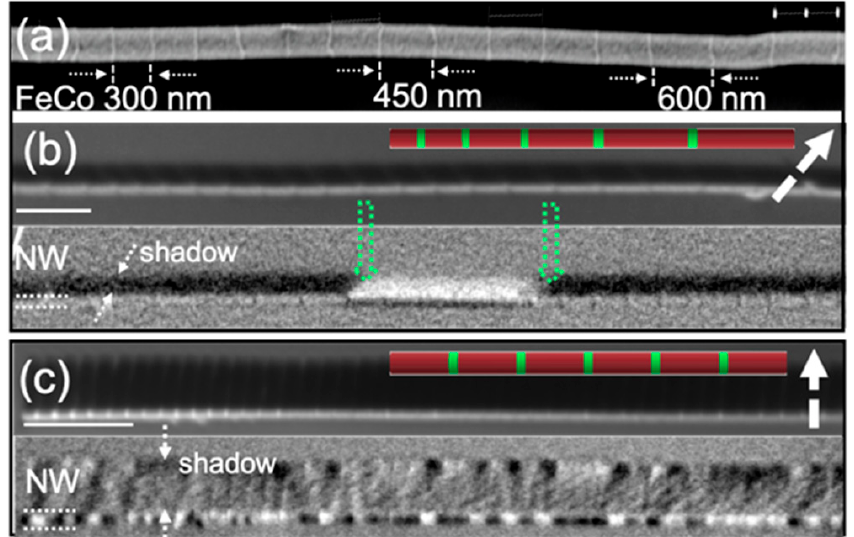
Figure 11. ( a ) SEM image of a multisegmented FeCo/Cu nanowire. Sequences of X-ray Absorption Spectroscopy (XAS) (above, with an indication of the beam direction: dashed white arrows) and PEEM images of ( b ) multisegmented FeCo/Cu nanowire with a variable length of FeCo segments, and ( c ) multisegmented FeCo/Cu nanowire with constant length of FeCo segments. The scale bar is 1 μ m.